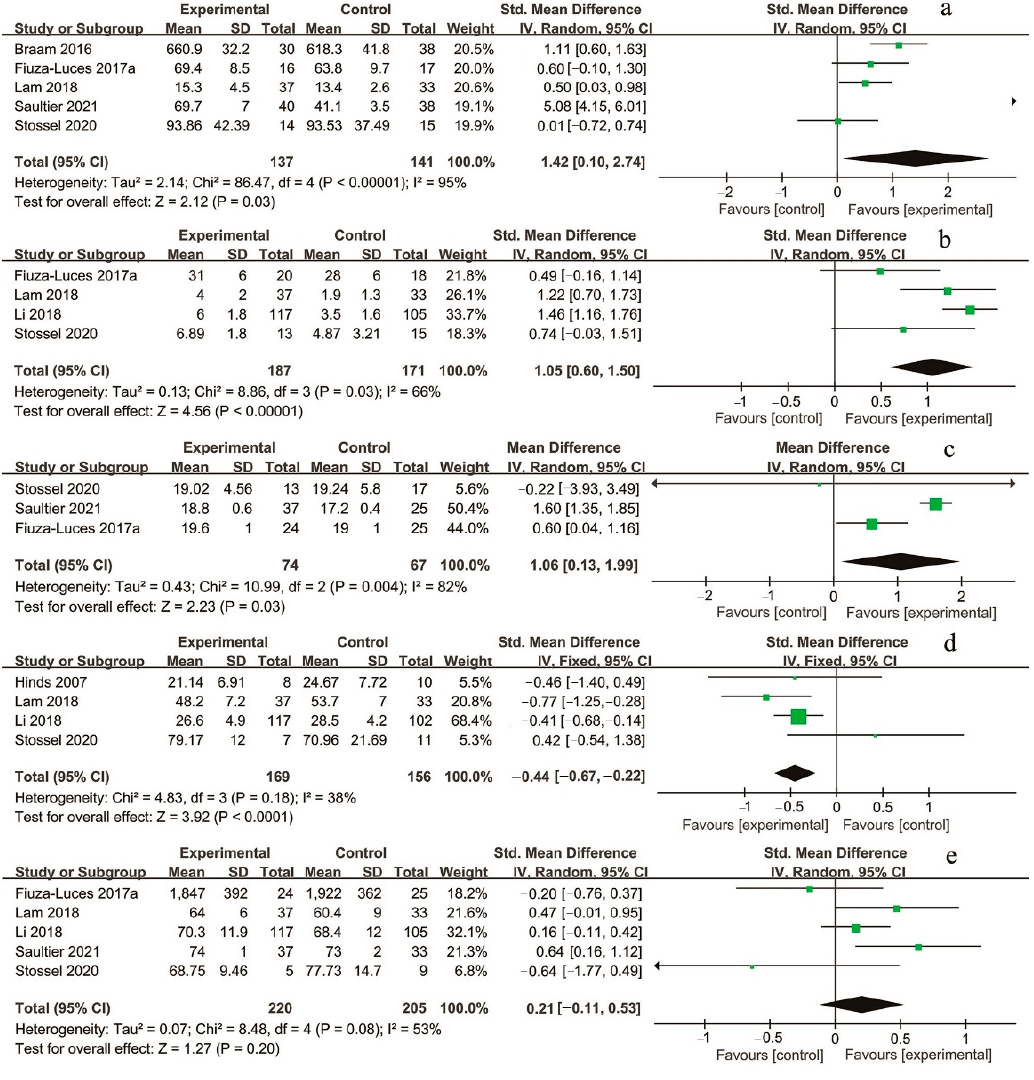
Figure 3. Meta-analyses of the effect of supervised exercise interventions on ( a ) muscle strength, ( b ) level of daily physical activity, ( c ) BMI, ( d ) fatigue, and ( e ) QoL.